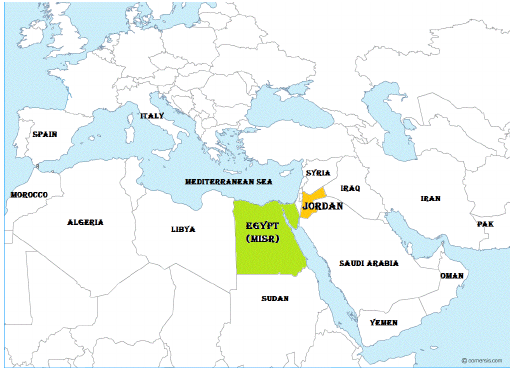
fig. 7, from the Late Paleocene of Tell Burma section, south Jordan ● ( non the holotype, pl. 81, figs. 8, 9), from Late Paleocene of Wadi Arab section, North Jordan, Fig. 2).